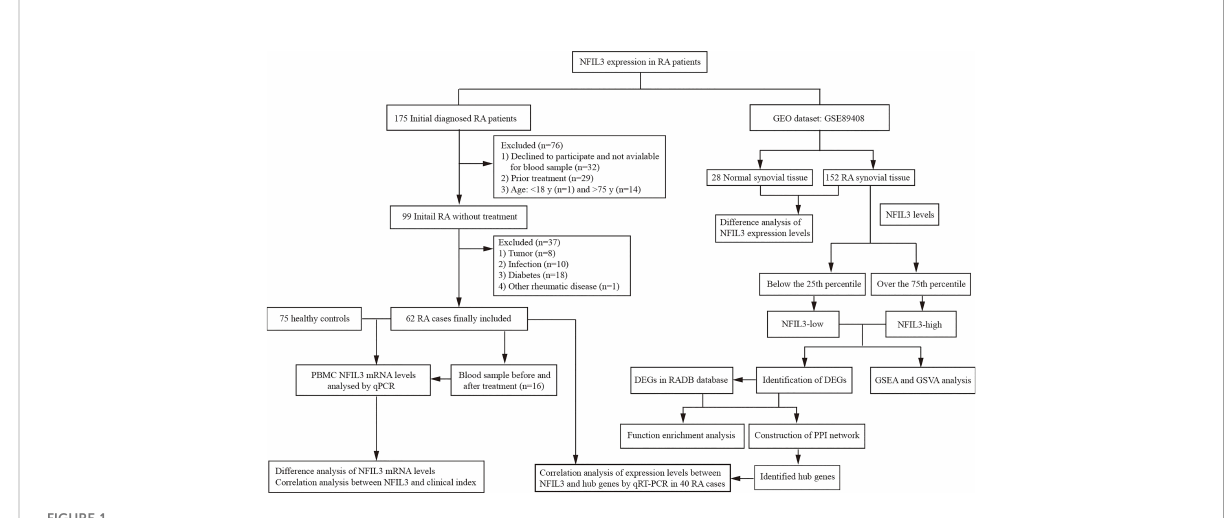
FIGURE 1 Overall work fl ow for analyzing NFIL3 expression in rheumatoid